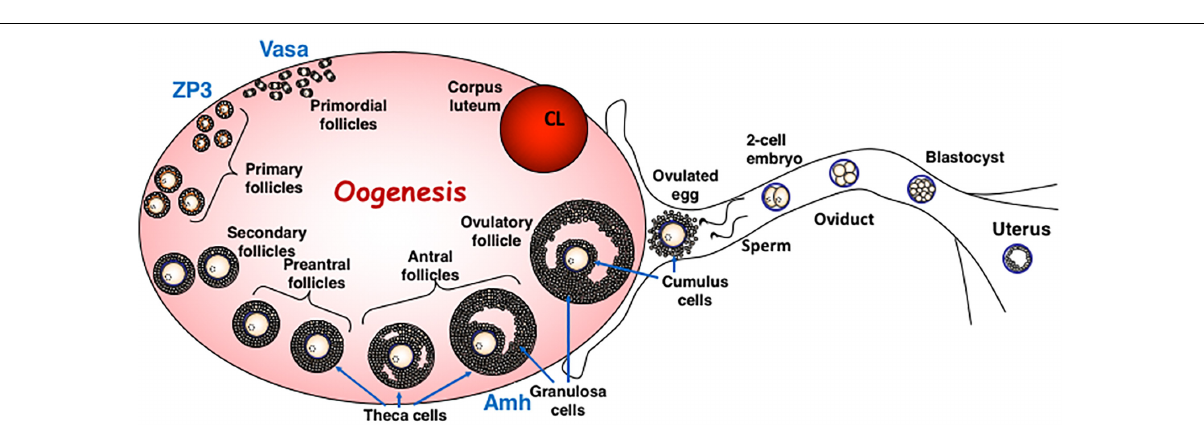
FIGURE 2 | Oogenesis in Mammals. The diagram describes the different stages of oogenesis and identifies the follicular stage in which the ZP3 and Vasa promoters are active in oocytes. Both these promoters are used for oocyte-specific deletion by Cre recombinase. The diagram is modified from Zhao and Dean (2002) with